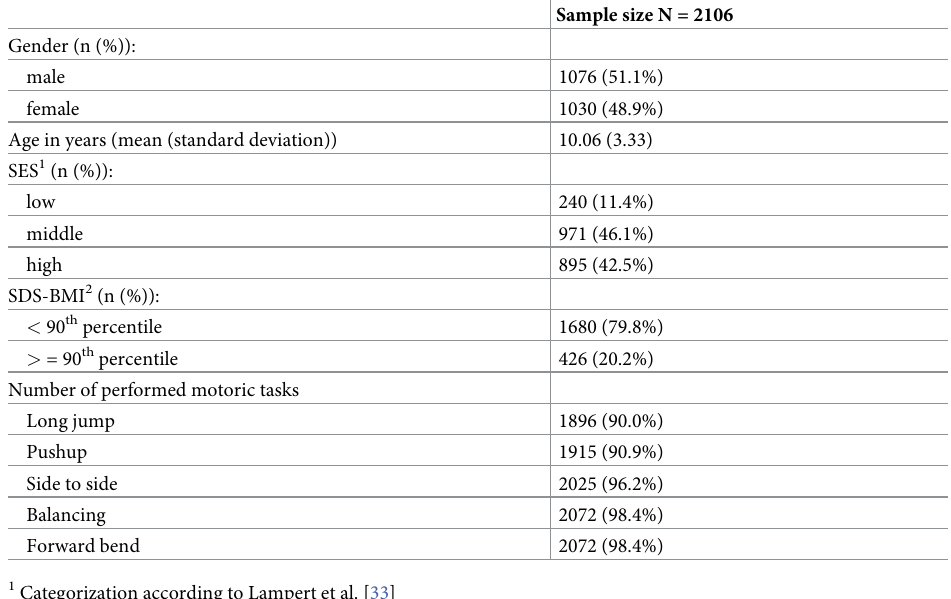
Table 1. Characteristics of the study